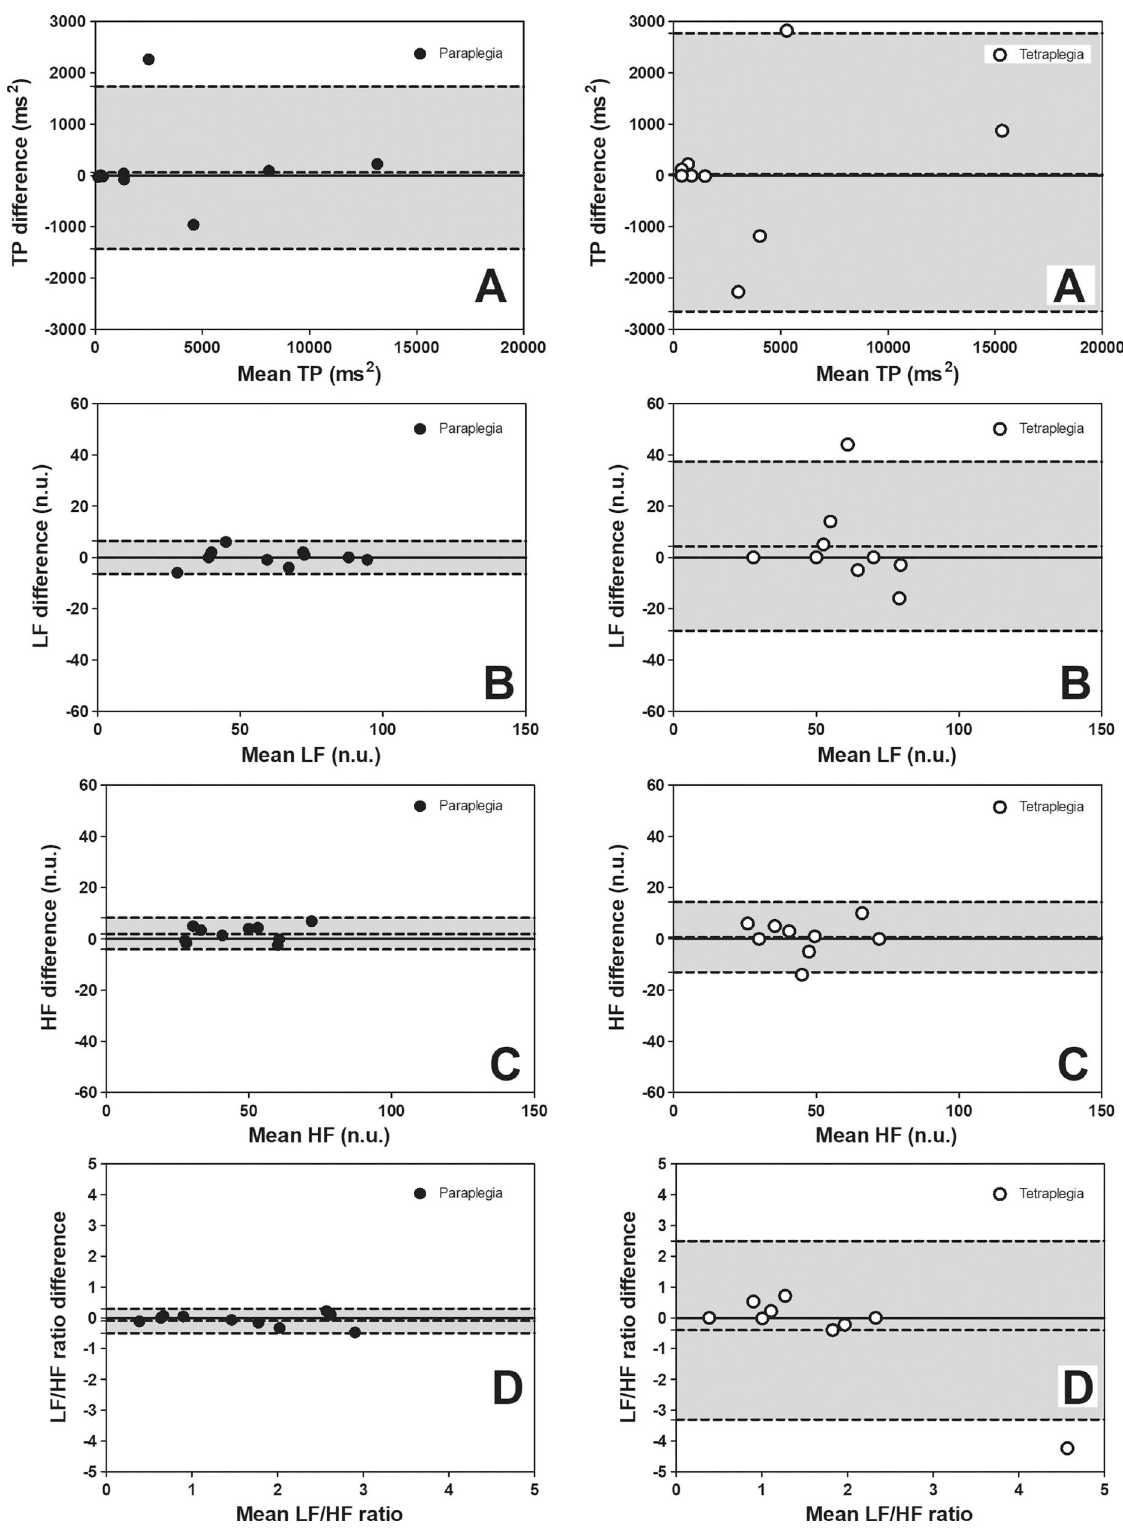
Figure 2 - Bland-Altman plot showing individual differences between HRV indices in frequency domain derived from ECG vs. Polar V800 in paraplegia (n = 10) and tetraplegia (n = 9) groups. The first and third horizontal dashed lines in each graph represent the 95% limits of agreement. S d = standard deviation of the differences. ( A ) TP = total power; ( B ) LF = low frequency component; ( C ) HF = high frequency component; ( D ) LF:HF ratio = sym- pathovagal